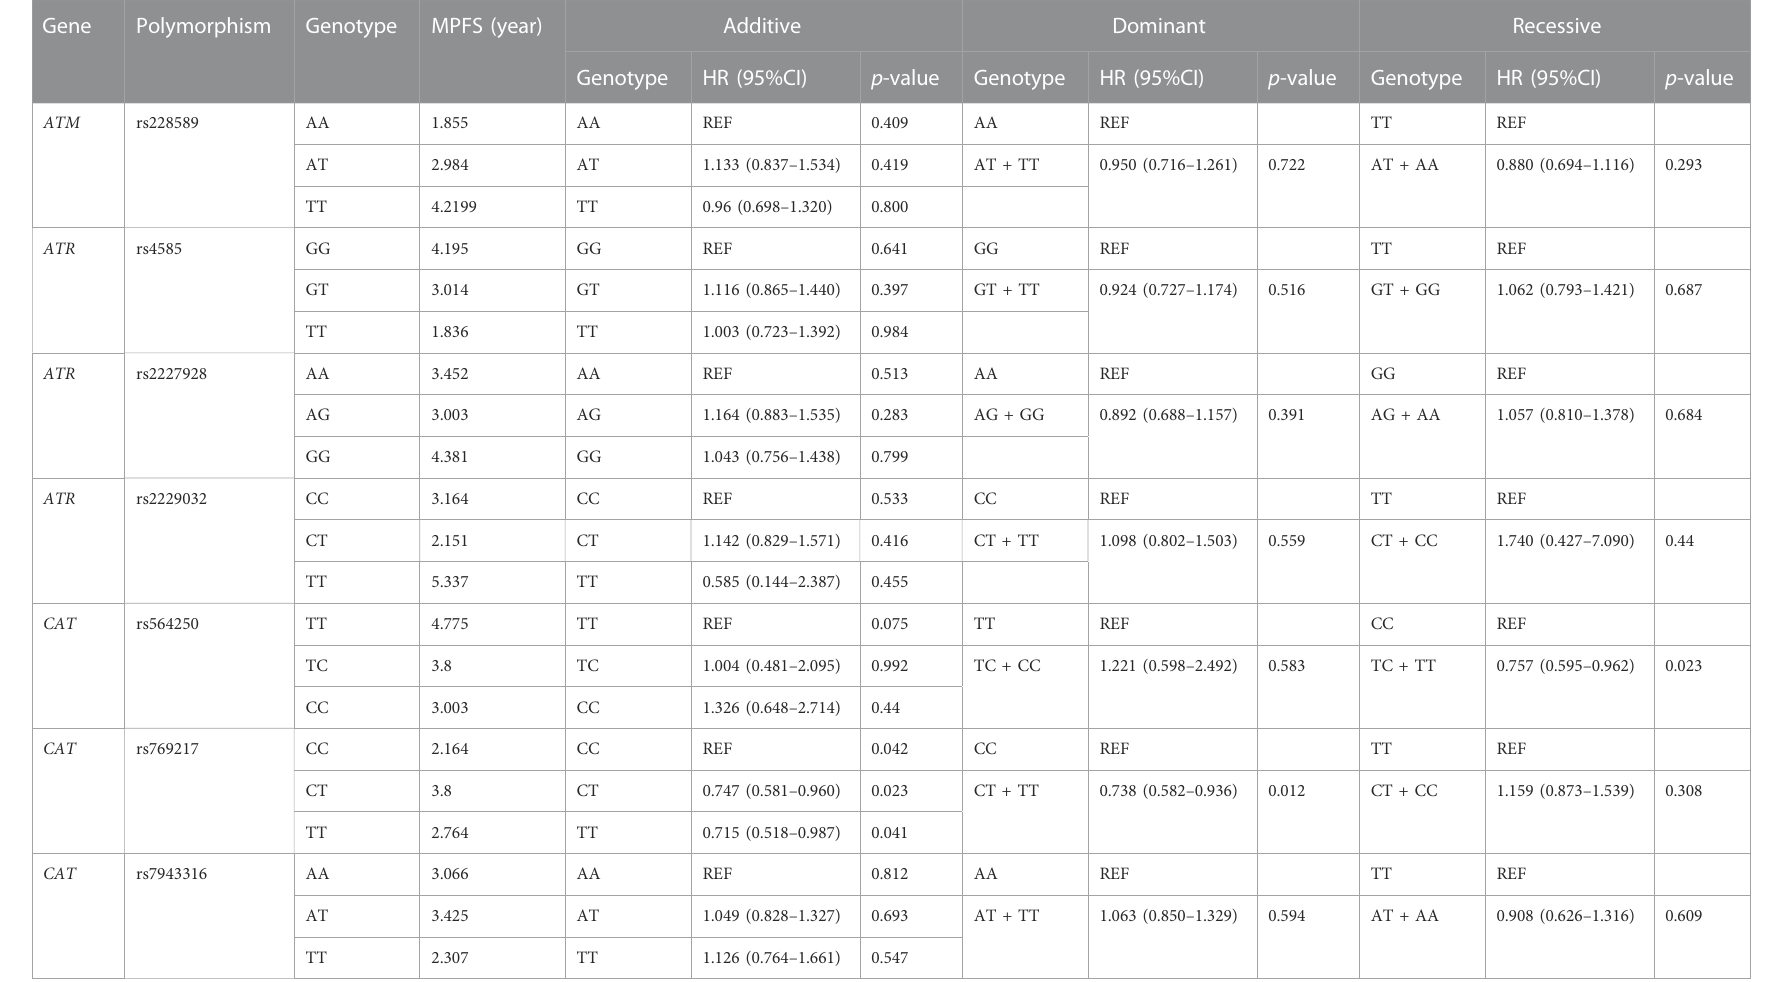
TABLE 2 Association of 7 SNPs polymorphisms and